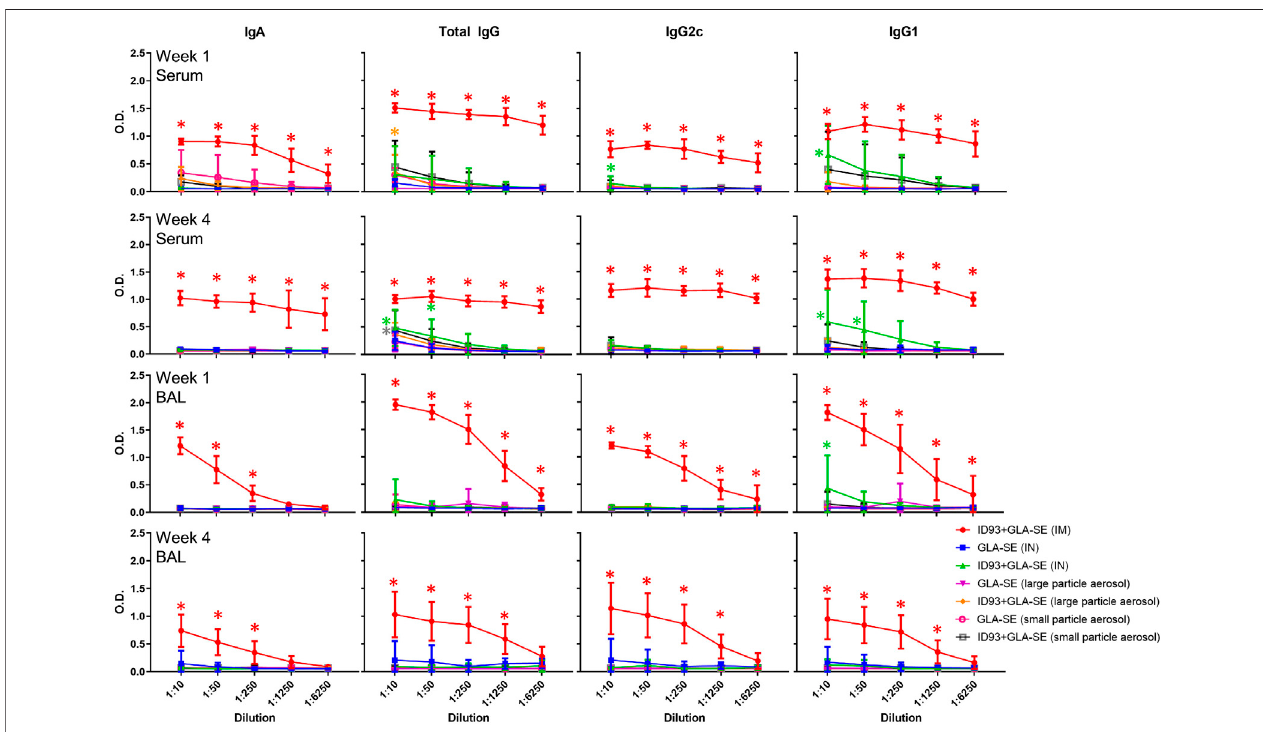
FIGURE 6 | IM vaccination with ID93+GLA-SE induces greater serum and mucosal antibody responses than alternative routes/presentations. B6 (n (cid:1) 7 – 8) mice were vaccinated with ID93+GLA-SE or only GLA-SE through intramuscular (IM), intranasal (IN), nasal aerosol delivery of large particle dry powder, or pulmonary delivery of small particle dry powder, at day 0 and day 21. Antigen-speci fi c IgA, total IgG, IgG2c, and IgG1 antibody responses in serum and bronchoalveolar lavage (BAL) were measured 1 and 4 weeks following the second immunization by ELISA. Data presented as mean ± SD. For simplicity, all statistical differences are represented as * p < 0.05 even when lower p -values were achieved. Each group immunized by IN or aerosol routes is compared to their adjuvant alone controls. The IM-immunized group comparison (red asterisk) represents statistical signi fi cance compared to all 3 alternative routes/presentations of ID93+GLA-SE. Statistical evaluation was conducted by two-way ANOVA with Tukey ’ s correction for multiple comparisons between selected